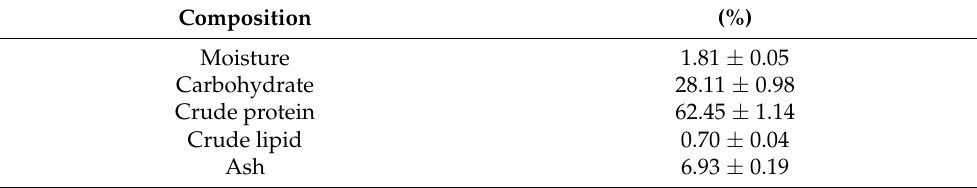
Table 1. Proximate compositions of S. pastorianus extract.